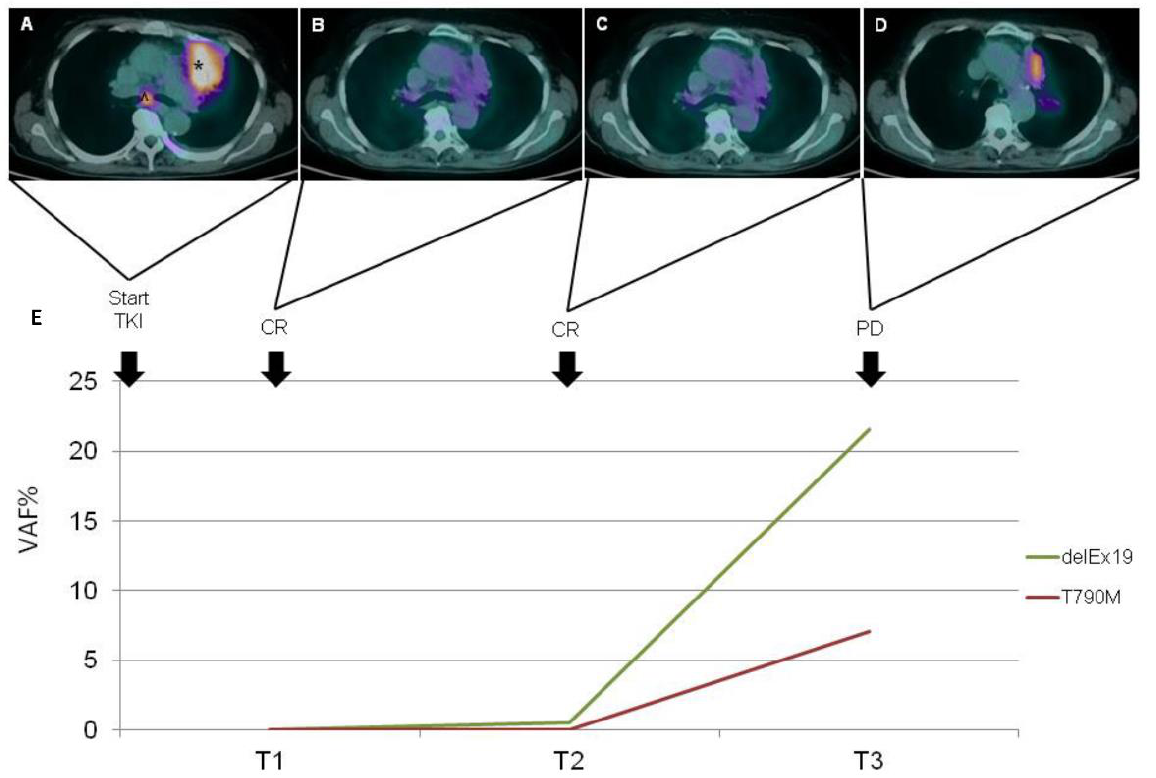
Figure 5. History of disease of the patient described as Case 2. Radiologic responses to TKI treatment paired with circulating activating and resistance EGFR mutation. PET-CT Images show size reduction without FDG-uptake, consisting with complete response, of the lung cancer localized in the left upper lobe (*) and adenopathy at subcarinal level ( ∧ ) from baseline ( A ) to controls at 3 and 6 months ( B , C ); PET-CT in the fourth image shows a relapse of tumor ( D ). Longitudinal VAF of delEx19 and T790M mutations in cfDNA ( E ).